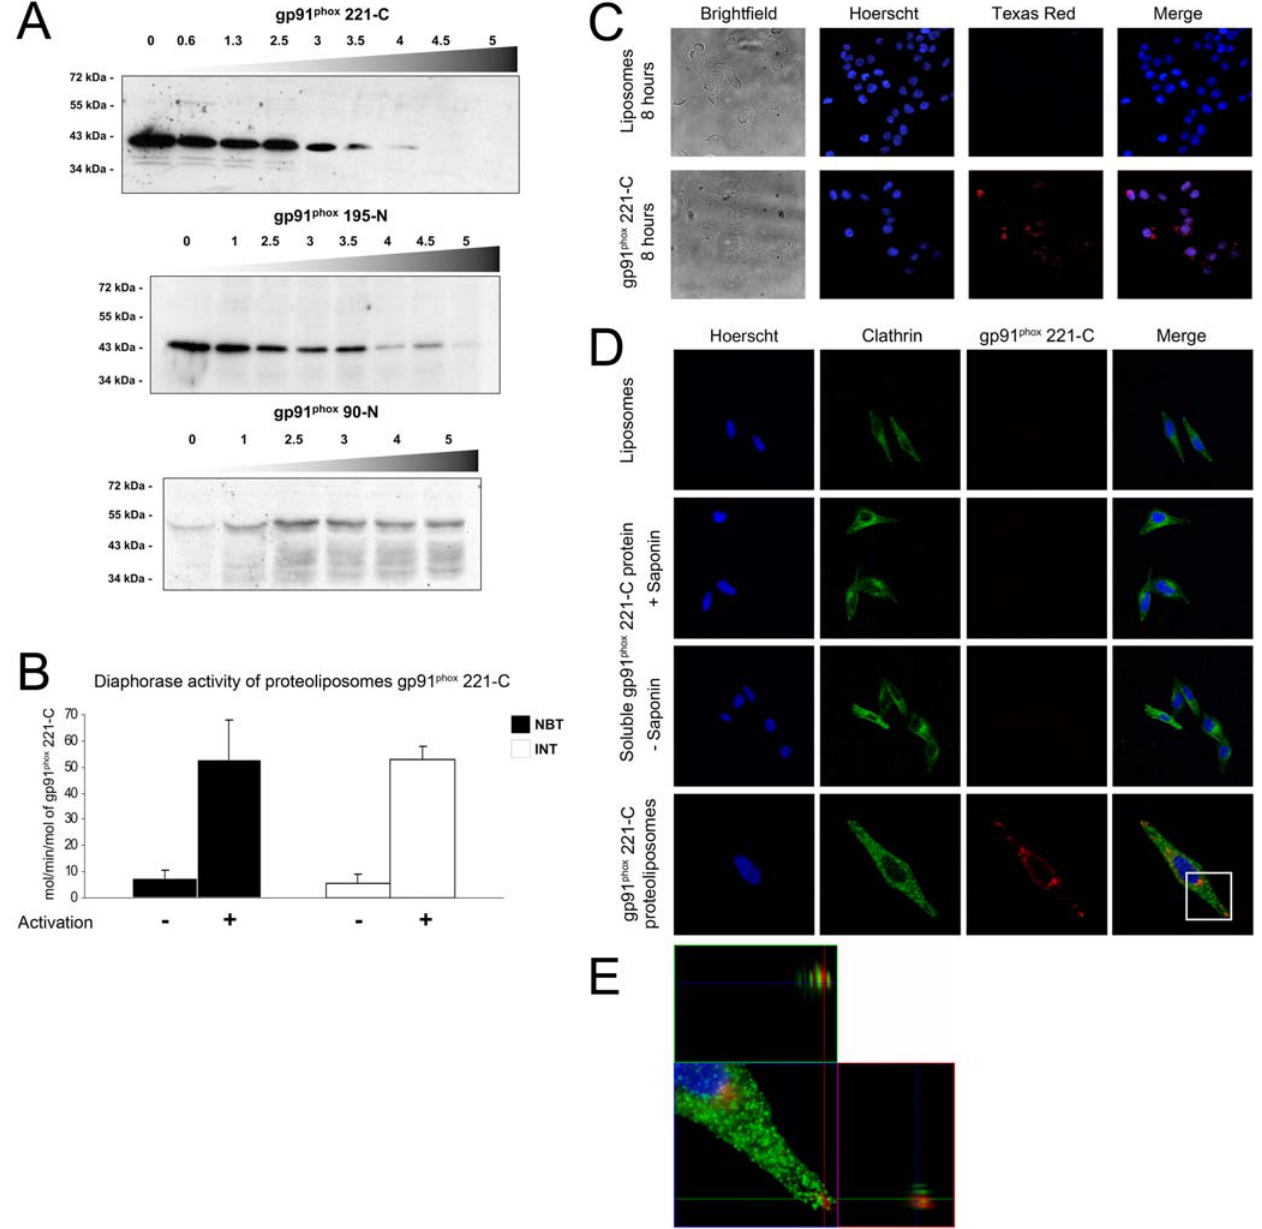
Figure 5. gp91 phox 221-C proteoliposomes. (A) Expression of membrane protein in presence of lipids analyzed by western blot using a monoclonal antibody anti-his. (B) Diaphorase assay of purified proteoliposomes gp91 phox 221-C using NBT or INT as electron acceptor, n $ 2. (C) Delivery gp91 phox 221- C with proteoliposomes in HCT116 cells after 8 hours of incubation. As a negative control, cells were incubated with the same amount (0.5 m g) of empty liposomes. The proteins were detected by fluorescence microscopy using a monoclonal anti-his antibody. (D) Confocal analysis of the distribution of gp91 phox 221-C proteindelivered withproteoliposomesin HeLa cellsafter8 hours ofincubation. Asa negative control,cells wereincubated with0.5 m g of empty liposomes or 0.5 m g of soluble gp91 phox 221-C. Cells were labelled for the exogenous protein using an anti-gp91 phox antibody (Red) and for the endogenous Clathrin(Green). The cells wereexamined undera ZeissLSM510(NLO) laser confocalmicroscope.Theimage plane was chosentobenearthe equator of the cell body and nucleus. (E) Higher magnification of the white boxed area in (D) with the respective xz